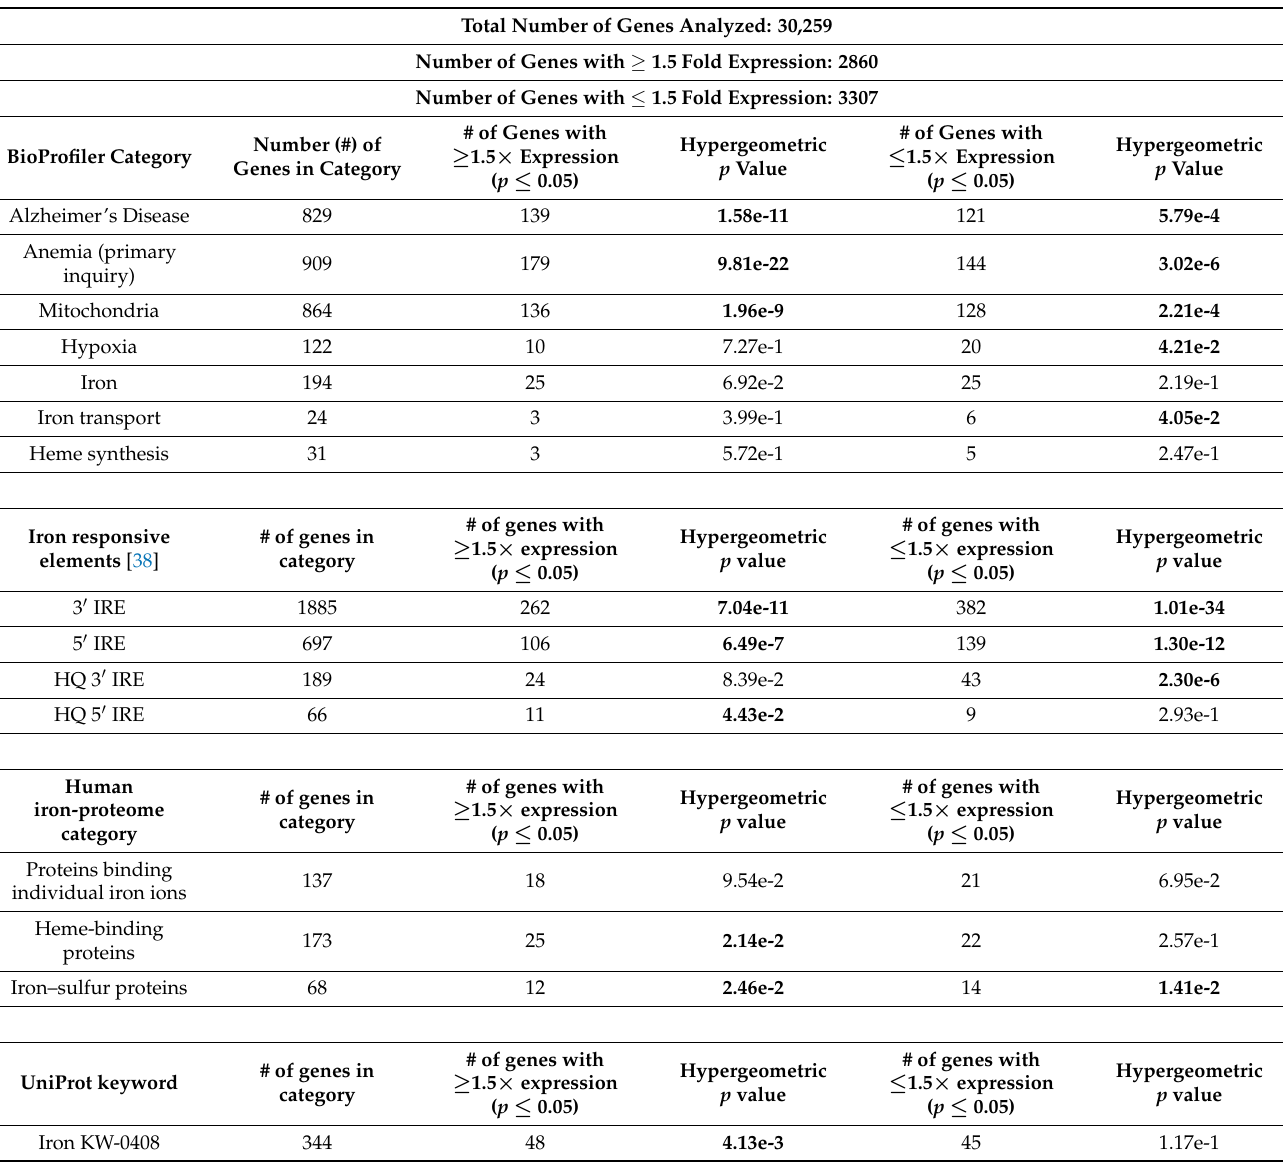
Table 1. Initial Stage AD Olfactory Bulb vs. Control Olfactory Bulb *. Total Number of Genes Analyzed: 30,259 Number of Genes with ≥ 1.5 Fold Expression: 2860 Number of Genes with ≤ 1.5 Fold Expression: